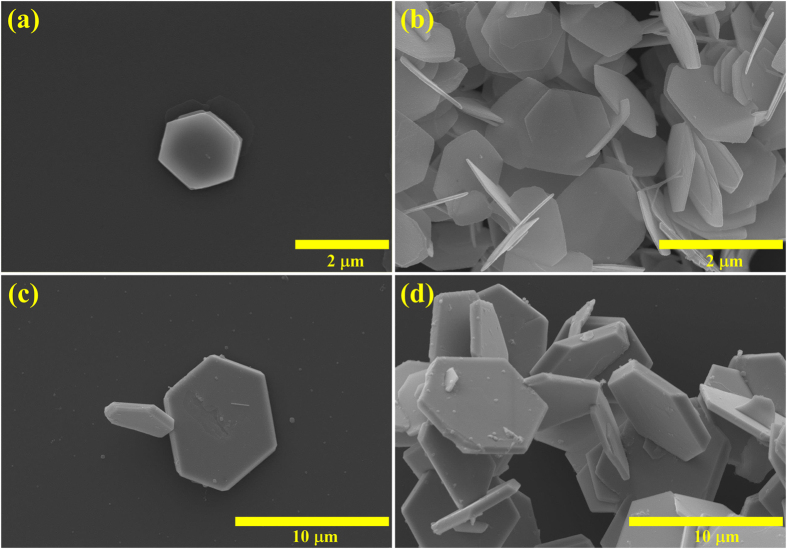
SEM image of the as-prepared Sb2Te3 nanoplatelets in thin platelets (a) and (b), and thick platelets (c) and (d).